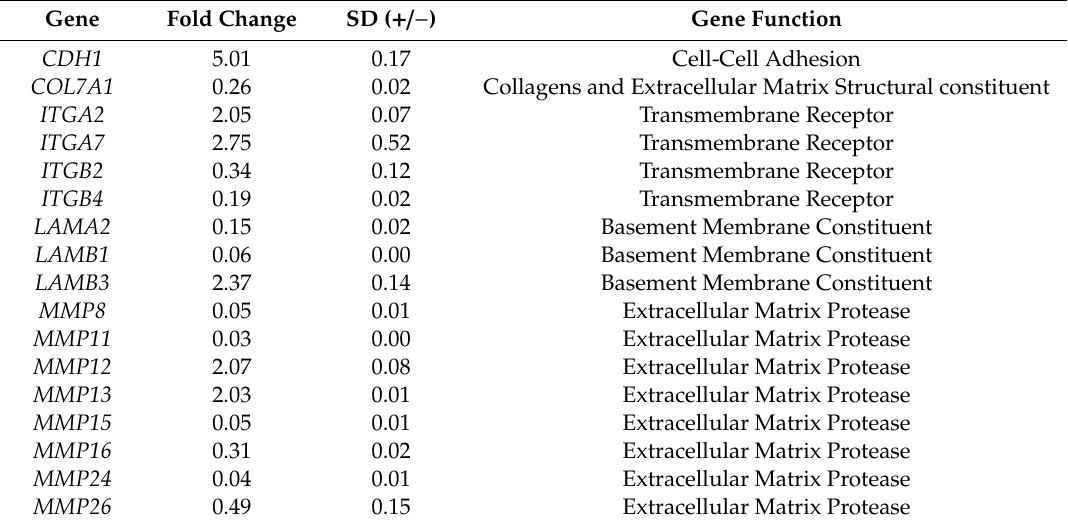
Table 4. Significant gene expression levels after 24 h of treatment with cyclosporine, as compared with untreated cells